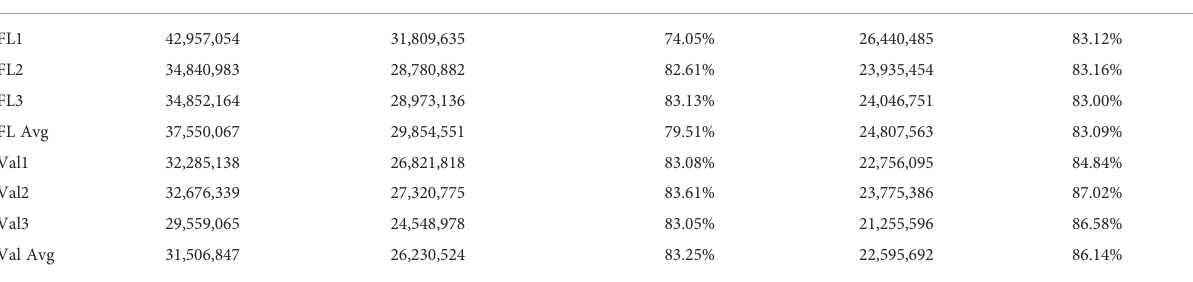
TABLE 1 Summary of sequencing, cleaning, and mapping of reads following sequencing the HLB infected fi nger lime and HLB infected ‘ Valencia ’